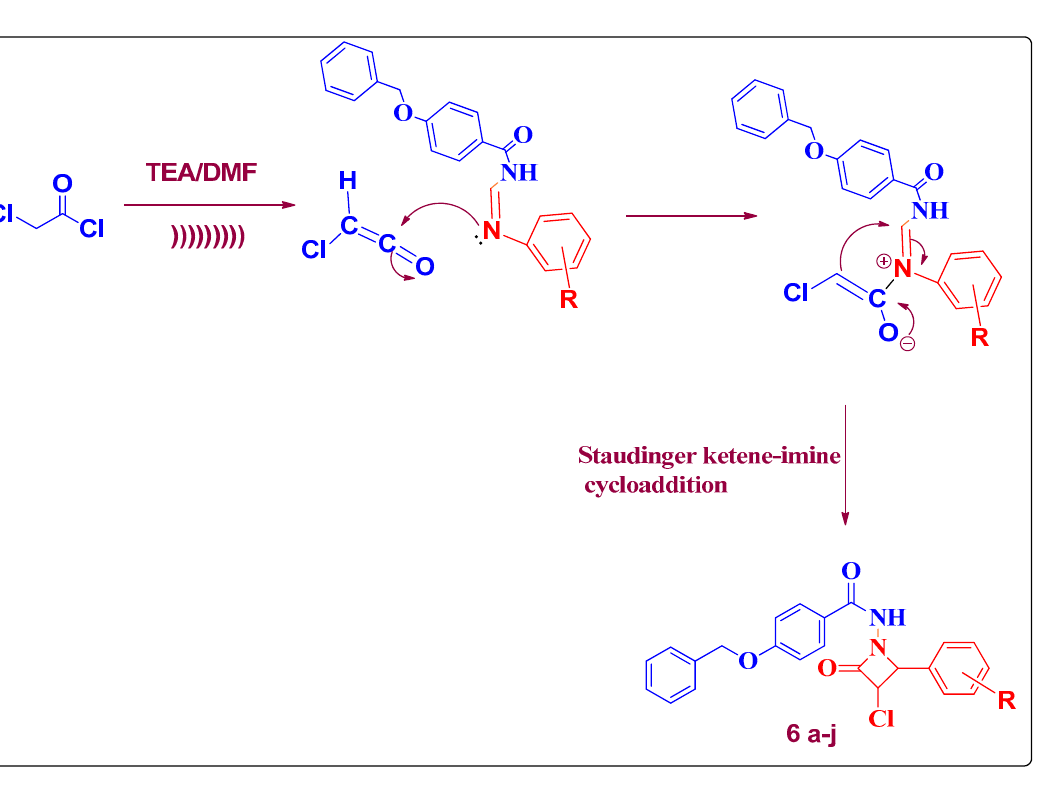
Figure 2. The mechanism of synthesis of 4-(benzyloxy)- N -(3-chloro-2-(substituted phenyl)-4- oxoazetidin-1-yl) benzamide 6a – j